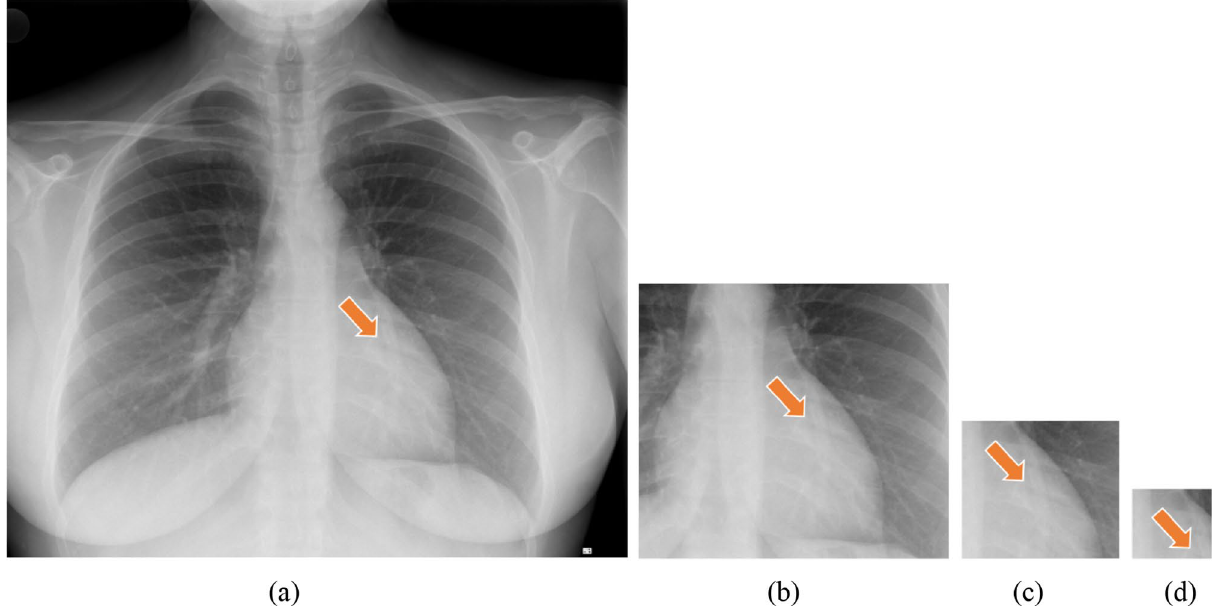
Figure 5. ( a ) Effect of patch resolution on identifying radiographic findings. An input CXR image of size W × H is divided into patch images of different sizes. ( b – d ) Examples of resulting patch images of sizes ( b ) W/2 × H/2, ( c ) W/4 × H/4, and ( d ) W/8 × H/8. The arrows identify the location of the patch images within the original input CXR